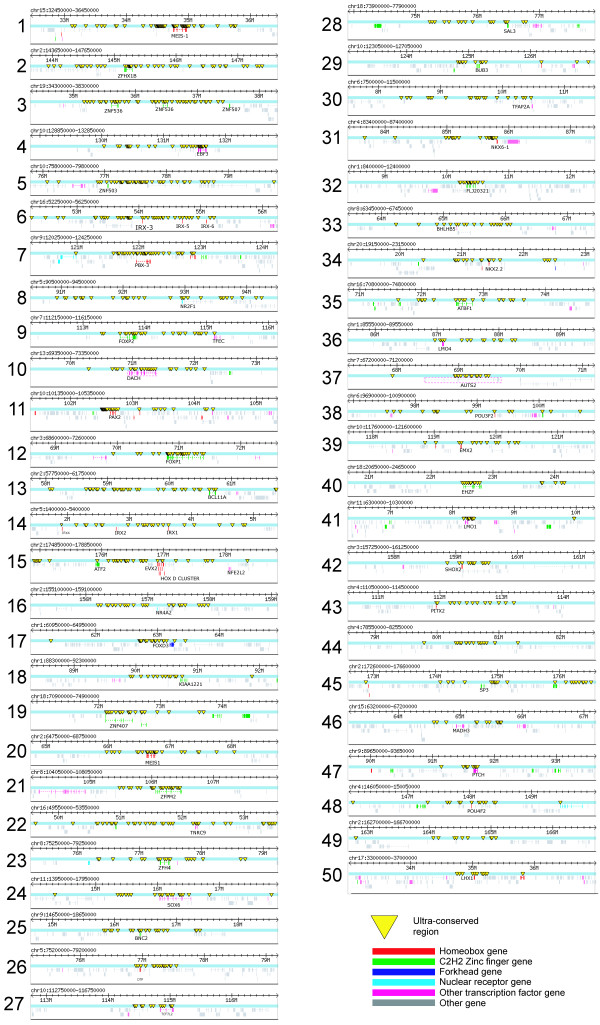
Genomic landscape surrounding the most prominent UCR clusters in the human genome. UCRs were counted by sliding a 500 kb window along the chromosomes. Overlapping UCR-containing windows were merged into a single cluster span. Each of the regions shows a 4 MB region around the corresponding UCR cluster. The cluster span coordinates correspond to the human genome NCBI build 33 (UCSC hg15, April 2003). Transcription factor genes are colored according to structural class. UCR clusters are visibly correlated with transcription factor genes; other developmental regulators that do not contain any of the probed protein domains were located manually (boxed), such as the autism susceptibility gene (chromosome 7, number 37) and the DACH gene (chromosome 13, number 10). The numbers correspond to annotations in [Additional file 6 and 7]. The figure was created with the help of the Bio::Graphics Perl library[27].